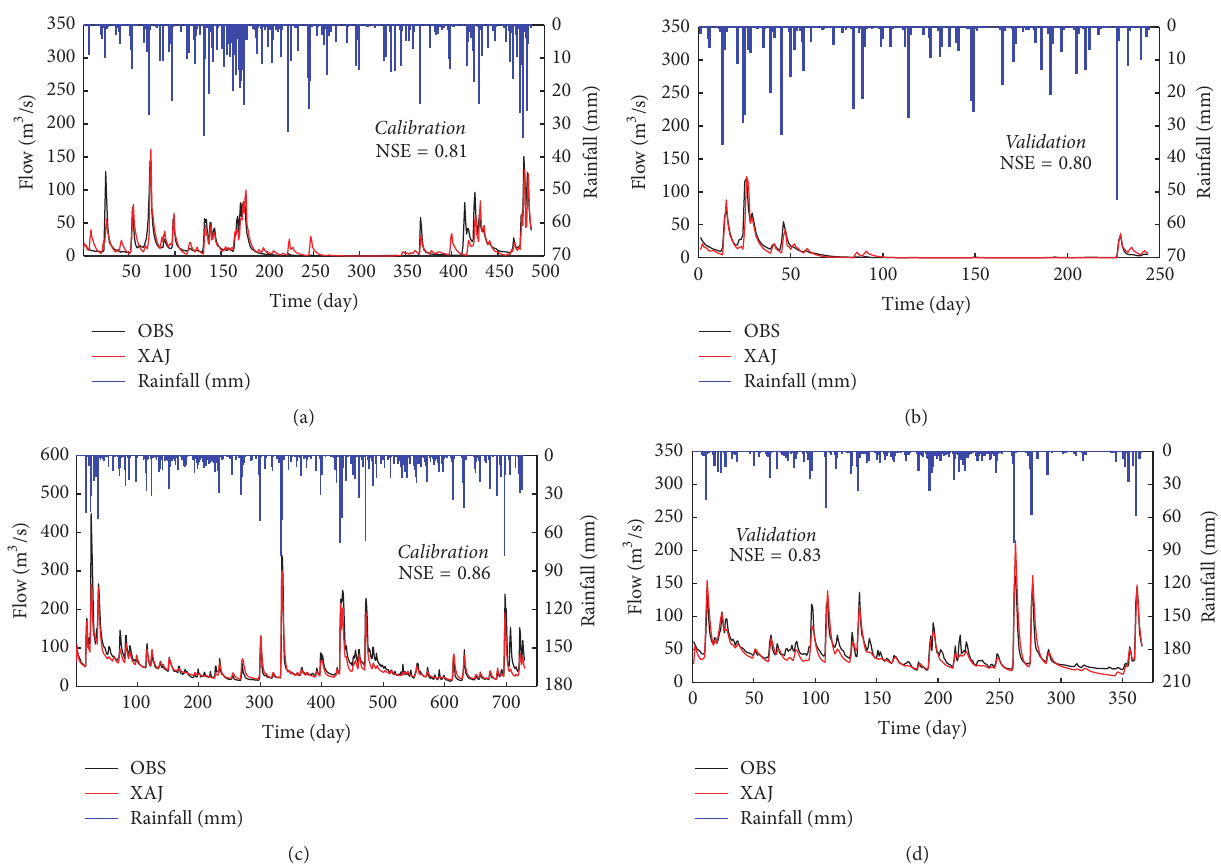
Figure 3: Daily rainfall and flow time series during the calibration and validation with the simulated hydrographs from the XAJ model in PB ((a), (b)) and in FBB ((c), (d)).